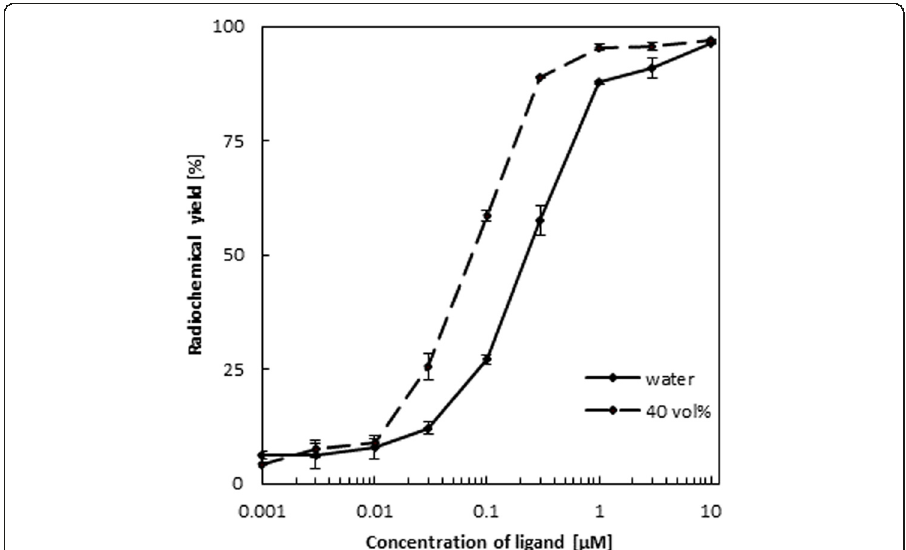
Fig. 4 Dependence of the radiochemical yield of 68 Ga-DOTATOC on the concentration of DOTATOC in presence of 40 vol% ethanol (0.003 – 31 nmol/0.001 – 10 μ M/0.0043 – 44.1 μ g DOTATOC, 95 °C, 5 min, n =